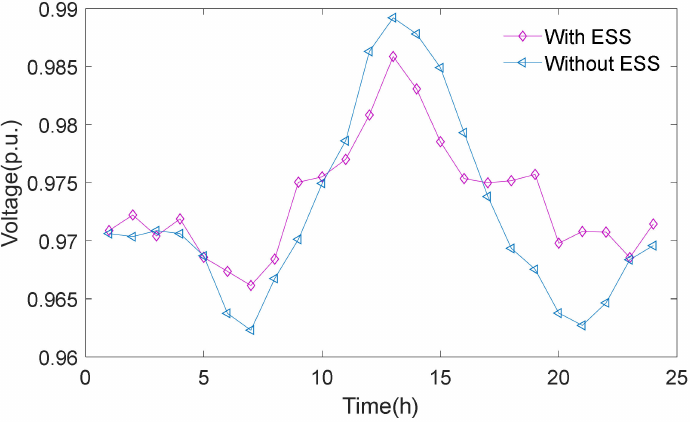
Figure 10. The fourth node voltage.